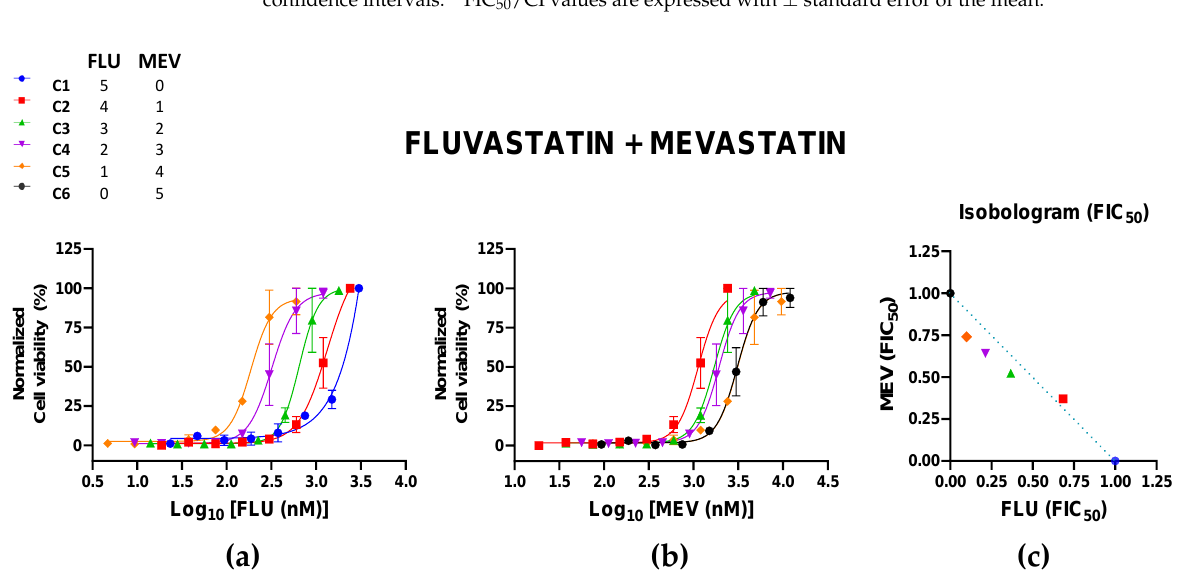
Figure 3. Effects of the combination of fluvastatin (FLU) and mevastatin (MEV) on Zika virus (ZIKV) infections. Vero cells were infected with ZIKV (MOI of 0.02) and treated with different combinations of FLU and MEV. Normalized cell viability of ZIKV-infected cells in response to the different concentrations of ( a ) FLU and ( b ) MEV in these different combinations are shown. All datapoints represent the mean ± SEM of 2 independent experiments per combination. ( c ) The normalized isobologram was constructed based on the mean FIC 50 of each statin (Table 3). Colors and symbols in the legend correspond to those in ( a – c ).